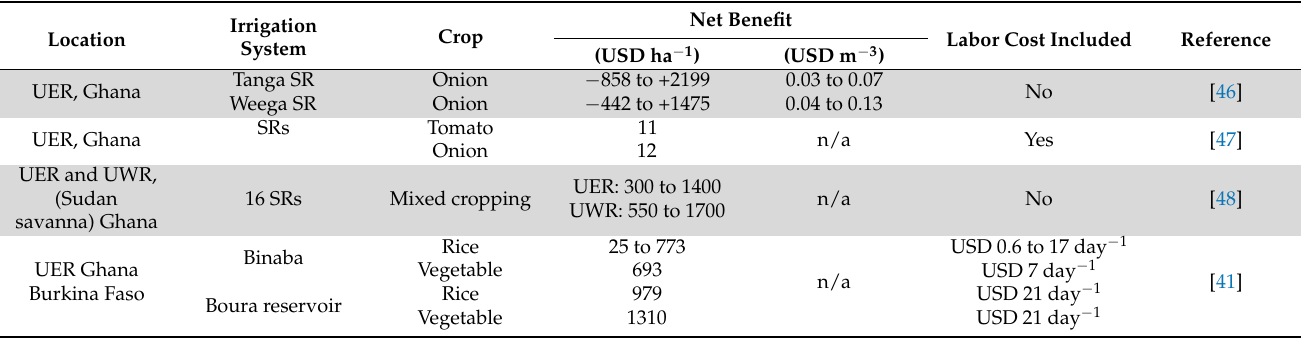
Table 5. Small reservoir irrigation returns.